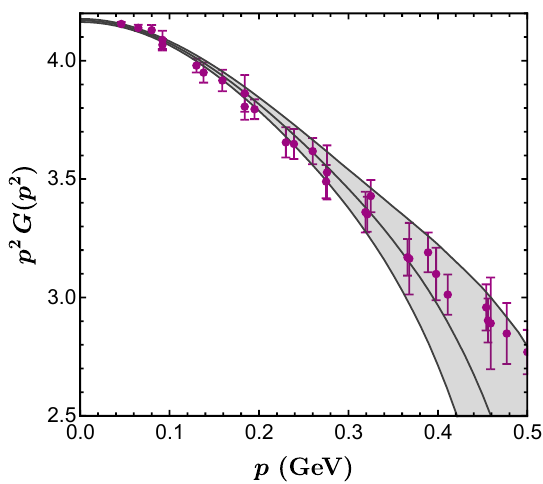
Figure 9 . Landau-gauge ghost-propagator Taylor series (gray) up to third order, using the results of table 6. The uncertainty band is the 68% confidence level, assuming a uniform distribution for the Taylor-series coefficients. The lattice data are shown in